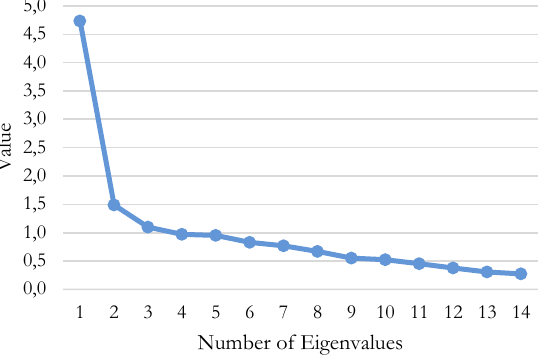
Fig. 2 – Scree diagram of eigenvalues for the factors defining sources of enterprise competitive advantage. Source: own research